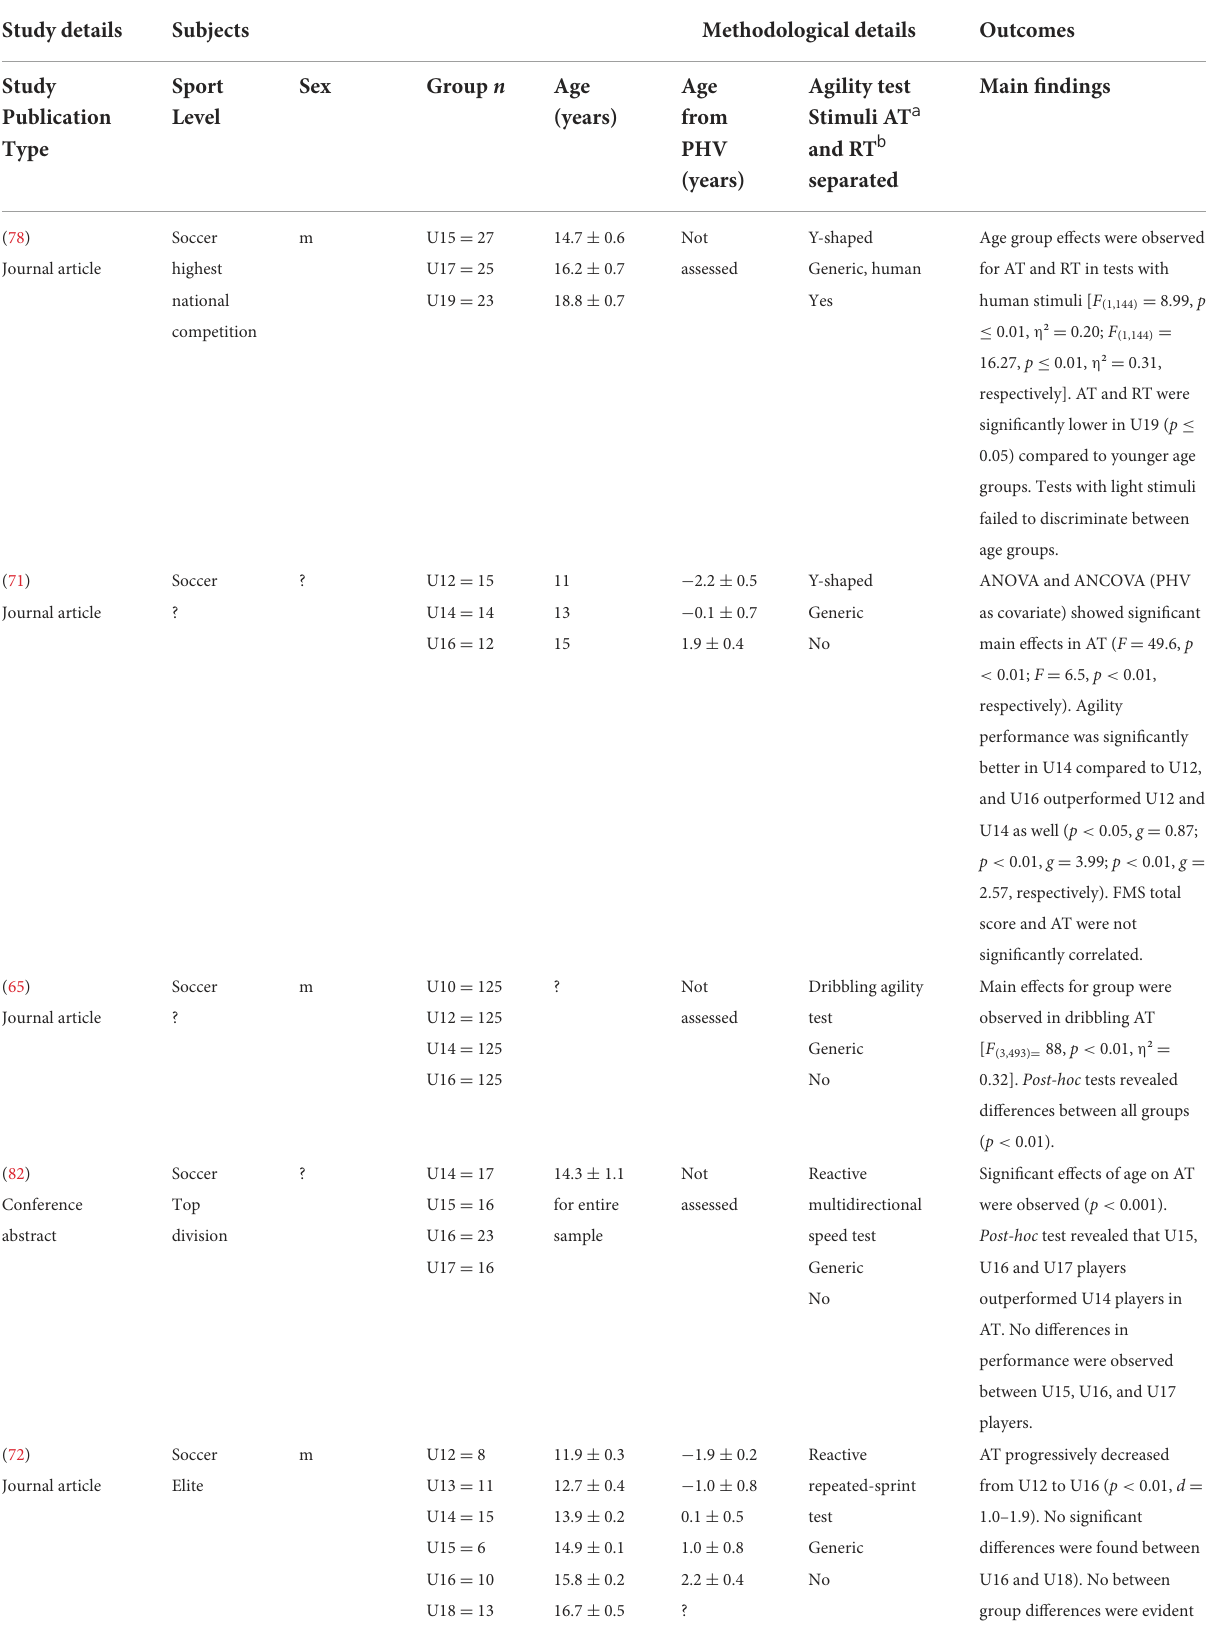
TABLE 1 Characteristics and outcomes of included observational